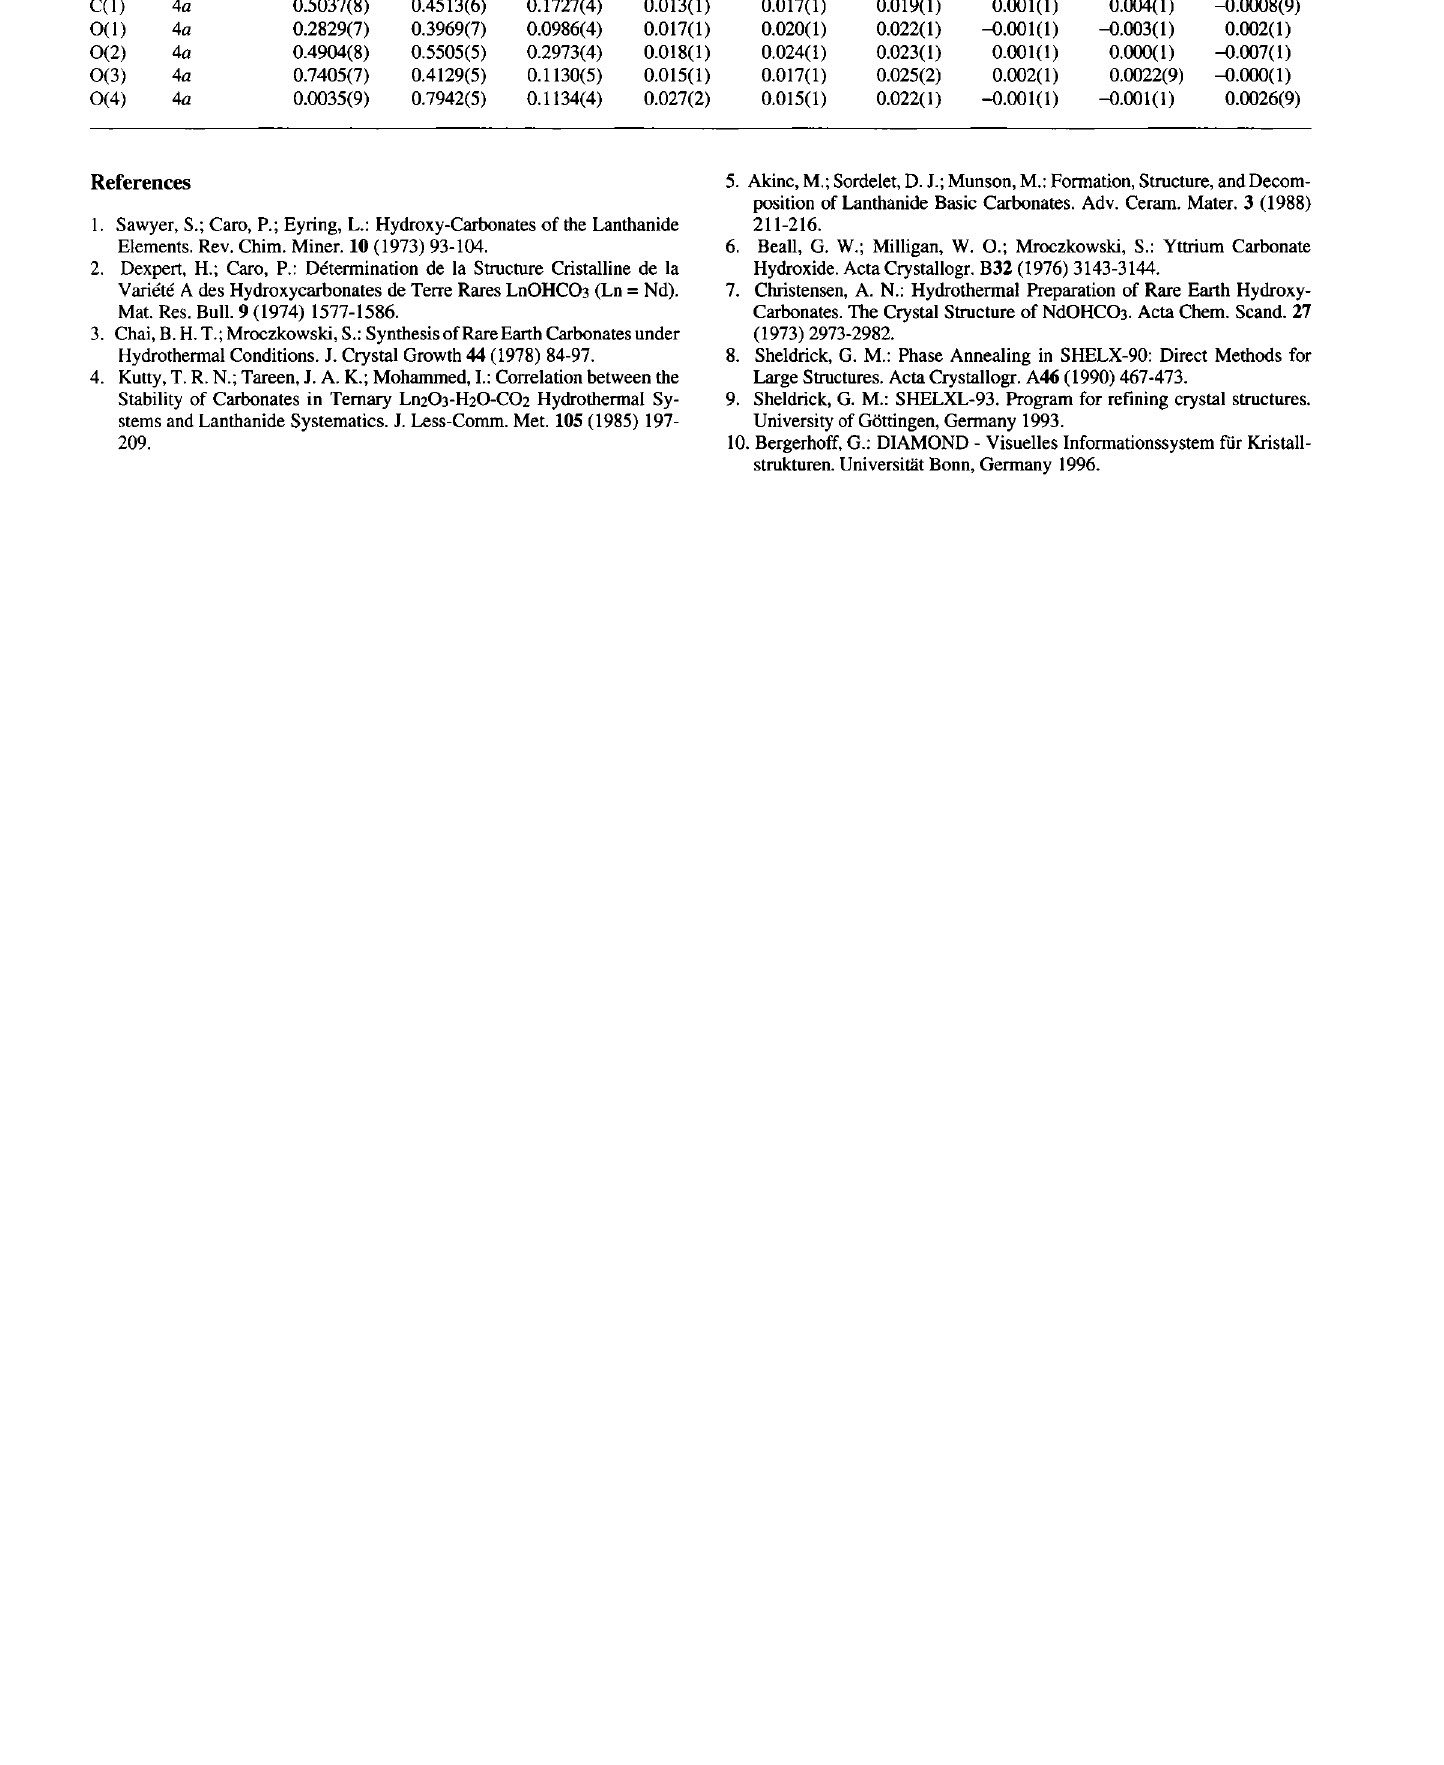
Table 2. Atomic coordinates and displacement parameters (in Â 2